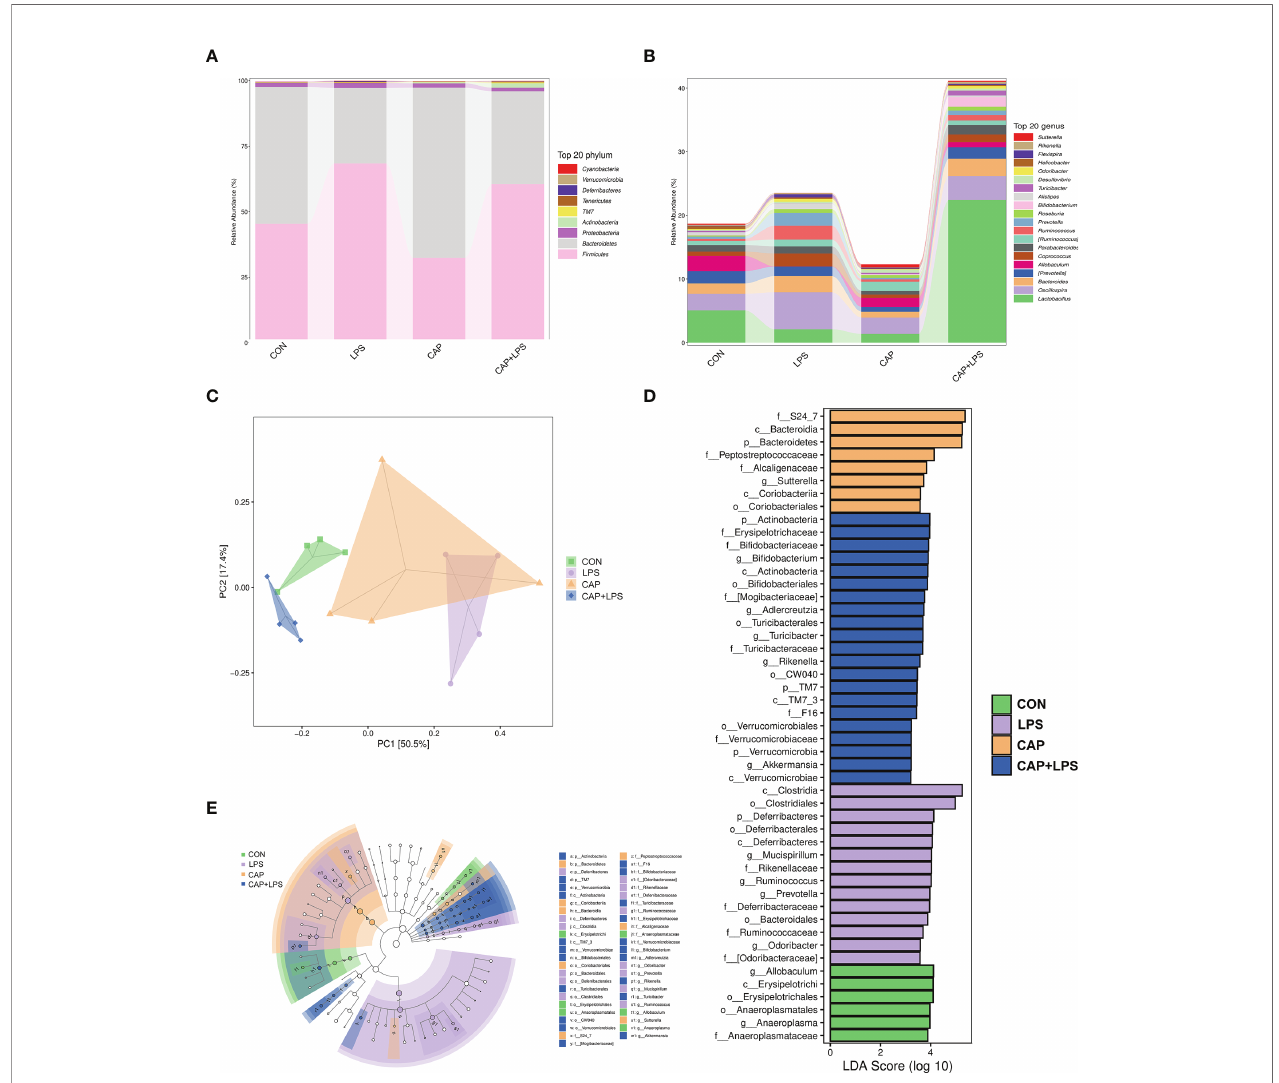
FIGURE 7 | (A) The community structures of different microbes at the phylum level in the four groups, colors indicate distinct microbe of phylum (n = 4); (B) The microbiota structures at the genus level in the four groups, different colors denote distinct microbe of genus (n = 4); (C) Orthogonal partial least squares discriminant analysis (OPLS-DA) of the microbiota in all groups (n = 4); (D) Linear discriminant analysis effect size (LEfSe) 10 was set up with 0.05 as the alpha value for Kruskal-Wallis and Wilcoxon test and then selected OTUs with LDA scores above 3 (n = 4); (E) LDA scores greater than 3 when comparing all groups, as described above (n =